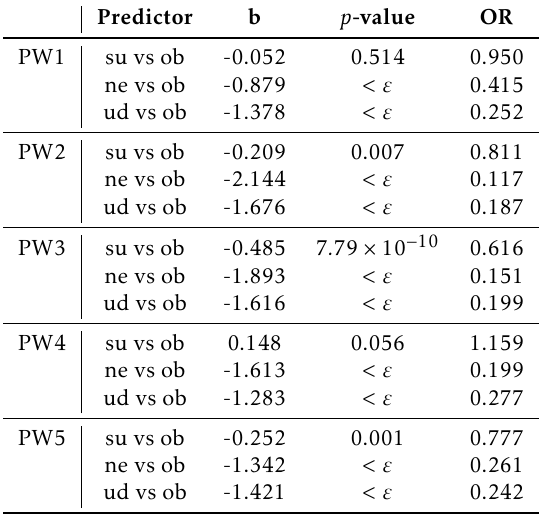
Table 8. Results of multinomial logistic regressions conducted on the displayed passwords as the predictor of participants’ self- reported trust.